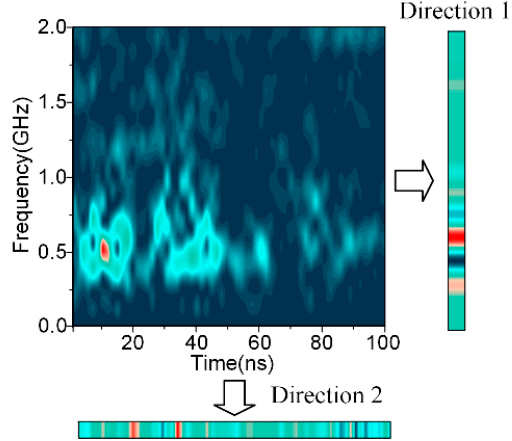
Figure 19. Visualization of the compressed results of the 2DPCA.